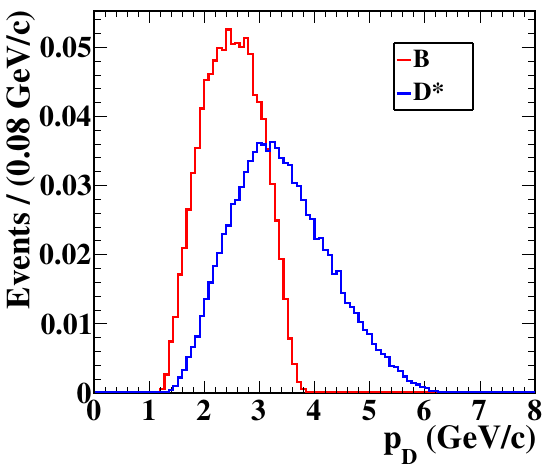
Figure 2 . Distributions of the measured D meson momenta p D in the lab frame for (blue) D (cid:3) + and (red) B + ! Dh + signal MC